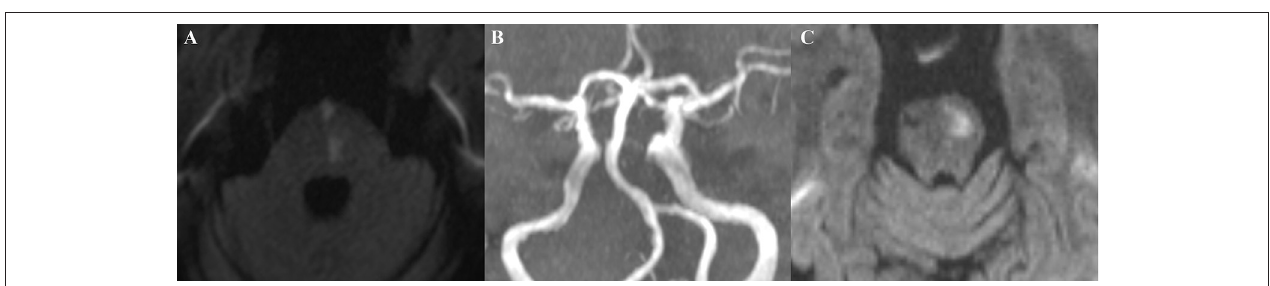
FIGURE 2 | A typical case: This patient, a 69-year-old man with a history of hypertension and diabetes mellitus, was admitted to our hospital with right upper and lower extremity weakness for two days (Medical Research Council scale, grade IV). DWI showed left paramedian pontine infarction (middle pontine) (A) ; MRA did not reveal basilar artery stenosis, while BA dolichosis and moderate curvature were noted (B) . The patient’s muscle strength returned to normal after treatment. Four years later, the patient again developed weakness in the right upper and lower extremities, and a repeat DWI suggested the left basal infarction of upper pontine (C) .